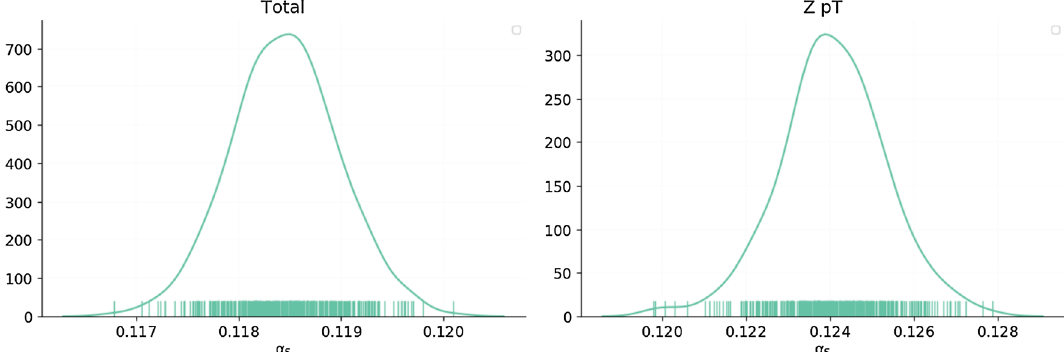
Eq. (5) respectively for the global dataset (left) and the Z p T P